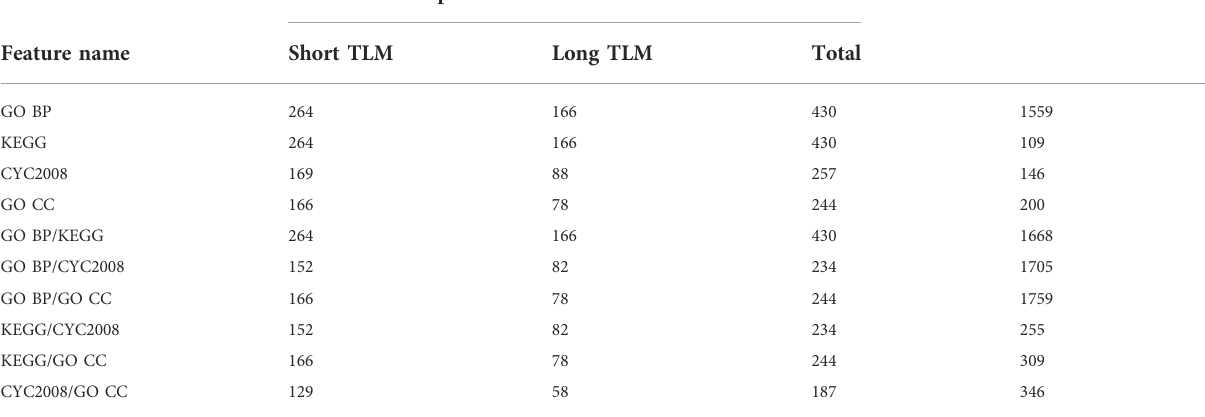
TABLE 1 Overview of the feature sets used to evaluate S. cerevisiae telomere length classi fi cation pipelines.